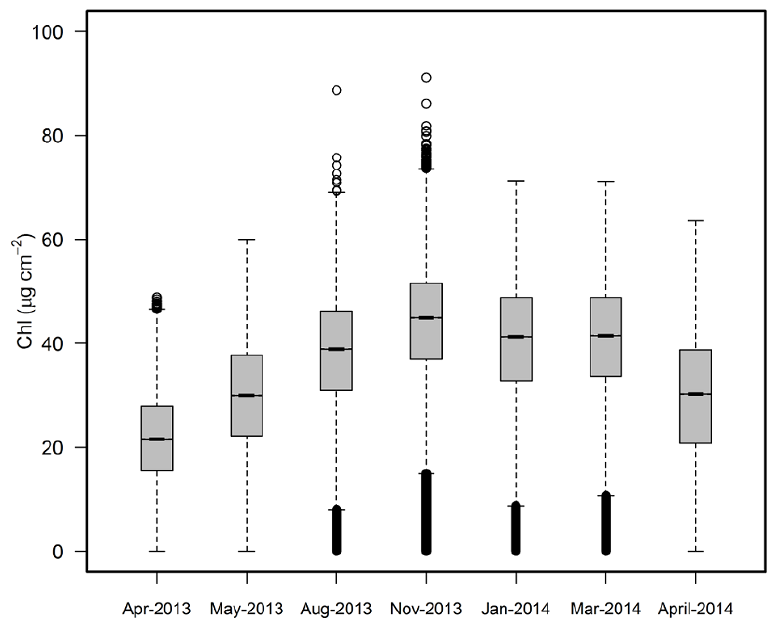
Figure 10. Temporal variation in CC. The boxes represent each CC map. Each box embodies the first and the third quartile. The bold line represents the median while the dark dot represents the mean. Whiskers are located at 1.5 times the interquartile range and white dots denote